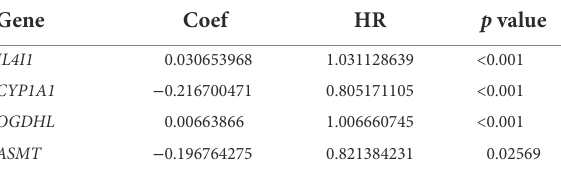
TABLE 1 Multivariate Cox regression analysis of four tryptophan metabolic prognostic genes associated with overall survival in glioma